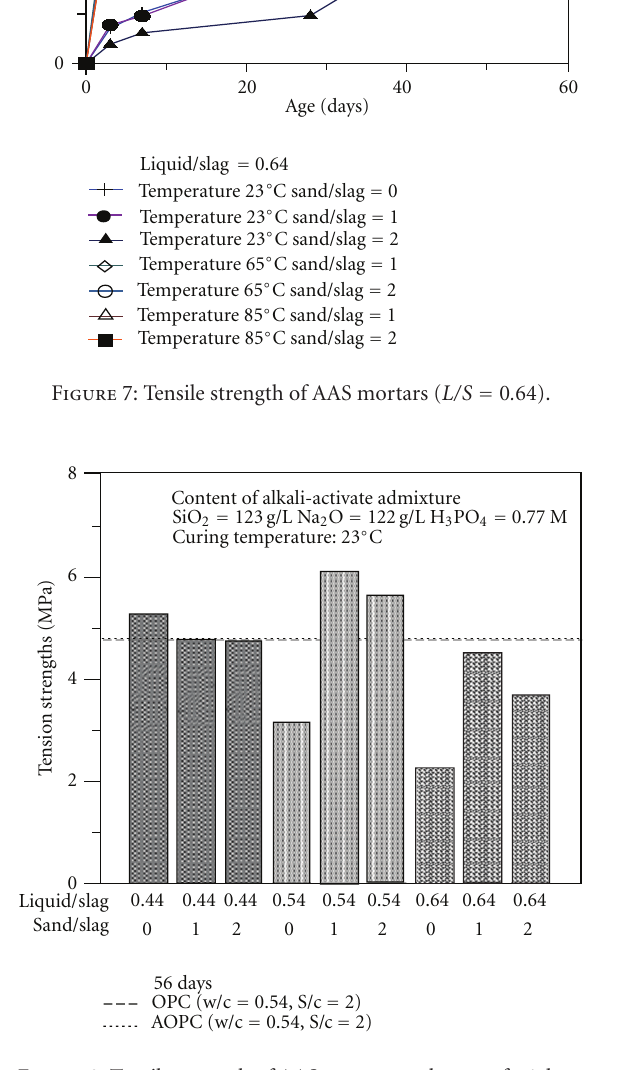
0.54 to that of the Portland cement mortar is 1.2. In general, the lower liquid/slag ratio leads to the lower workability.